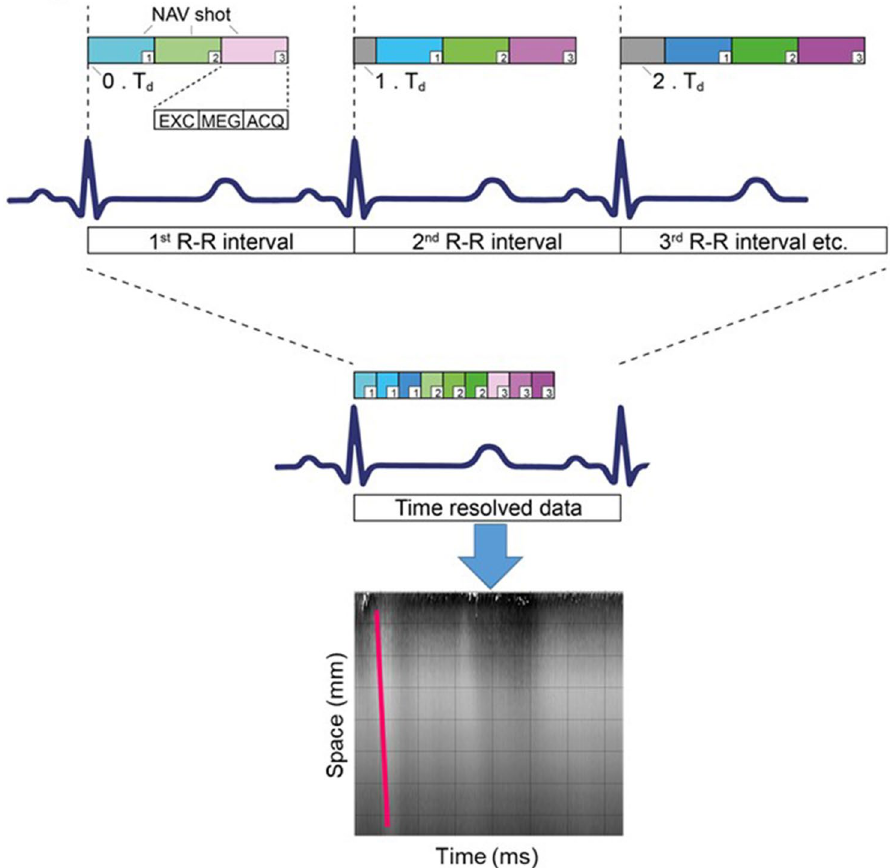
Figure 3. Image acquisition and data re-sorting. Multiple cNAV shots (~ 40) are acquired during each heartbeat. For each subsequent heartbeat, an additional temporal delay T d is introduced (grey area) to shift the NAV acquisition relative to the closure of the aortic value. Data are re-sorted afterwards according to their temporal position relative to the R-wave. This allows to obtain temporal resolutions up to 0.3 ms, two orders of magnitude below the duration of each NAV (20 ms). EXC excitation pulse, MEG motion-encoding gradients, ACQ readout